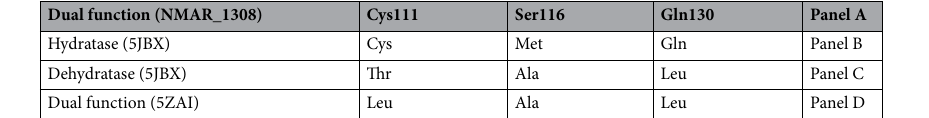
Table 2. The residues implicated in the dual-function based on multiple sequence alignment in Fig.